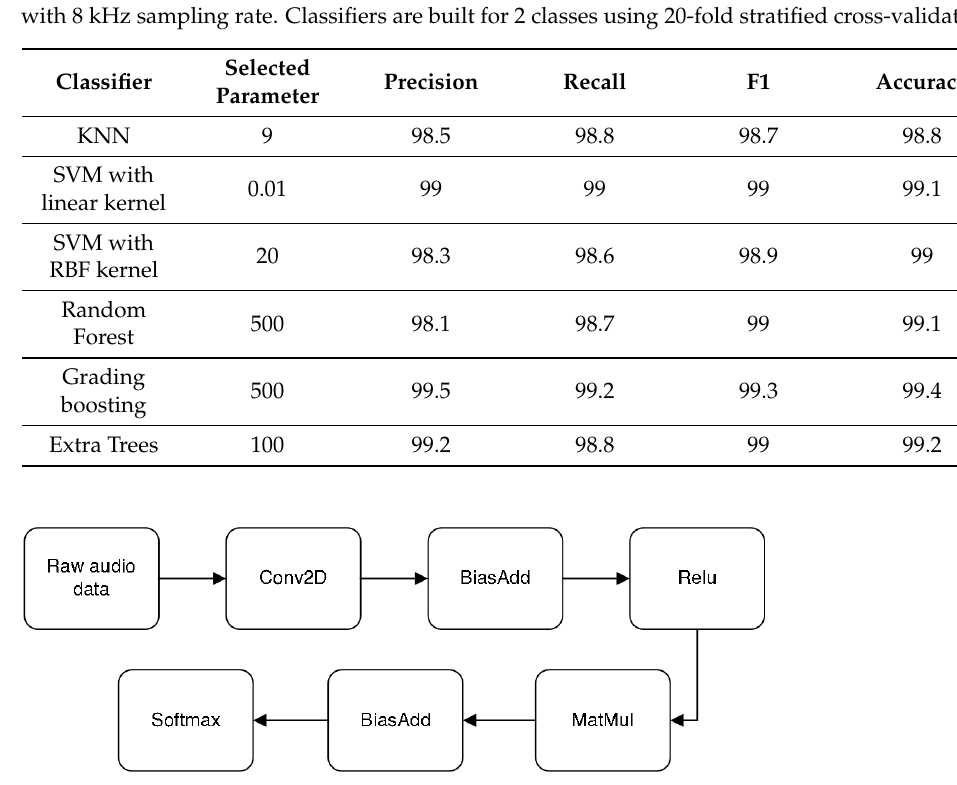
Figure 20. Convolutional model aimed at microcontrollers.